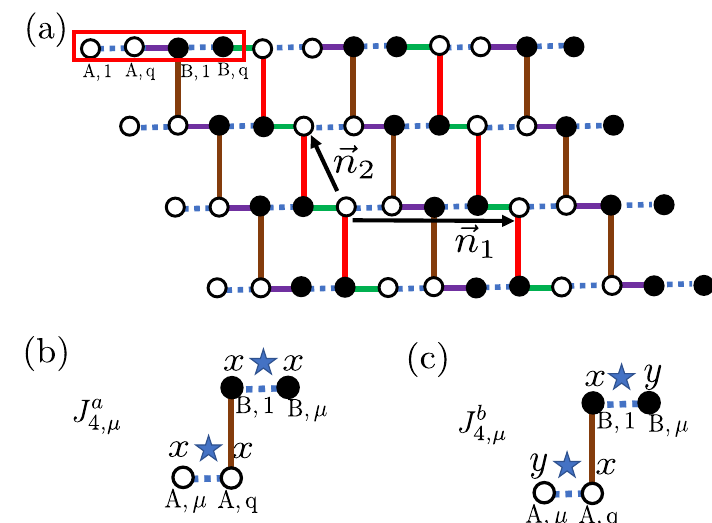
, B , 1 in each plaquette of the former 2 terms and J b terms in H even and H even , a 4, µ 4, µ b